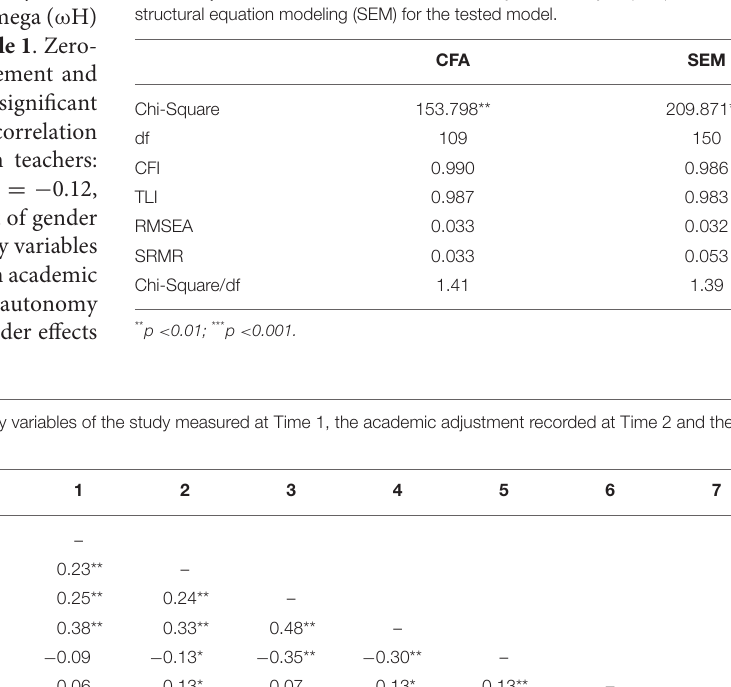
Table 3 . The fit of the models for the CFA and the SEM met the multiple criteria for adequate model fit. Overall, both for CFA and SEM models, factor loadings of each latent variable were